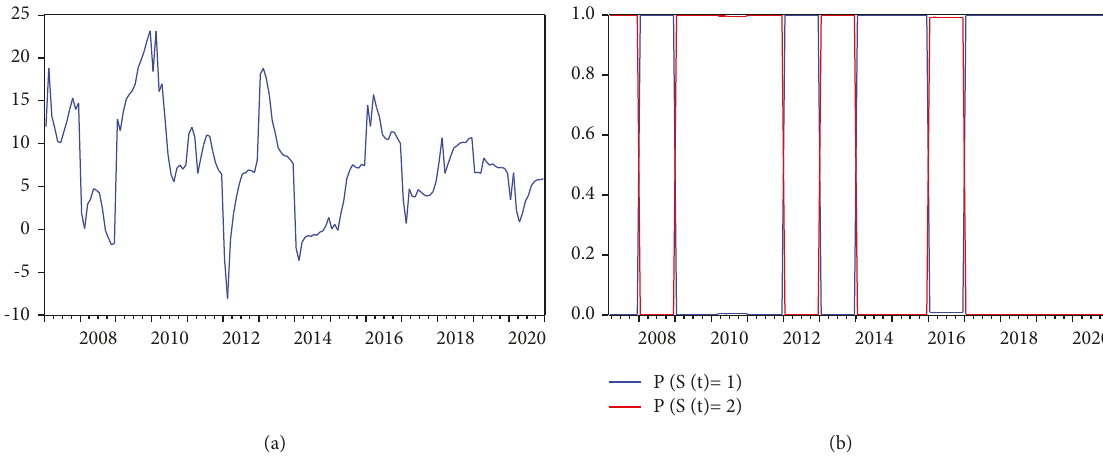
0.240.260.280.300.320.340.360.380.40